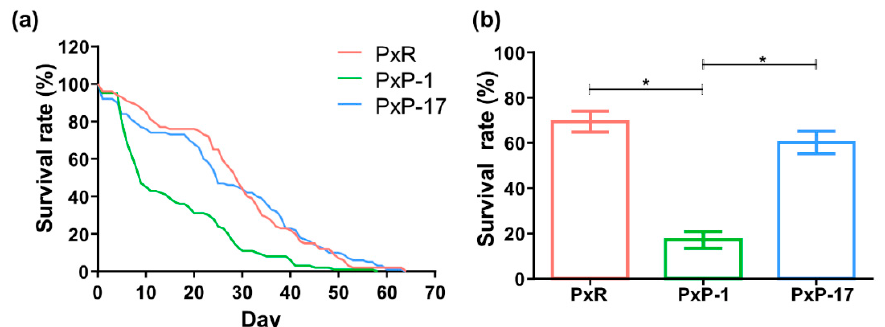
Figure 7. Survival rate of P. xylostella eggs to adults feeding on di ff erent host plants. ( a ) Accumulating survival curve; ( b ) survival rate. PxR: P. xylostella feeding on radish; PxP-1 and PxP-17: the 1st and 17th generation of P. xylostella , respectively, feeding on peas after host shift from radish. Student’s t test was performed between different treatments. “*” indicates p < 0.05.